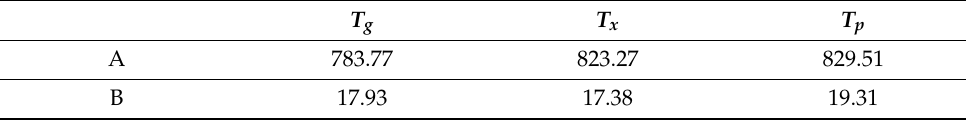
Figure 10. Relationship between ln β and characteristic temperatures of the Fe 68 Nb 6 B 23 Mo 3 glassy alloys. Table 3. Values of A and B of the Fe 68 Nb 6 B 23 Mo 3 glassy alloys.